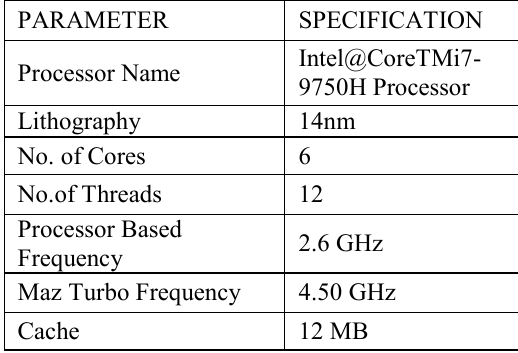
Table 2 : CPU Intel@CoreTMi7-9750H Processor